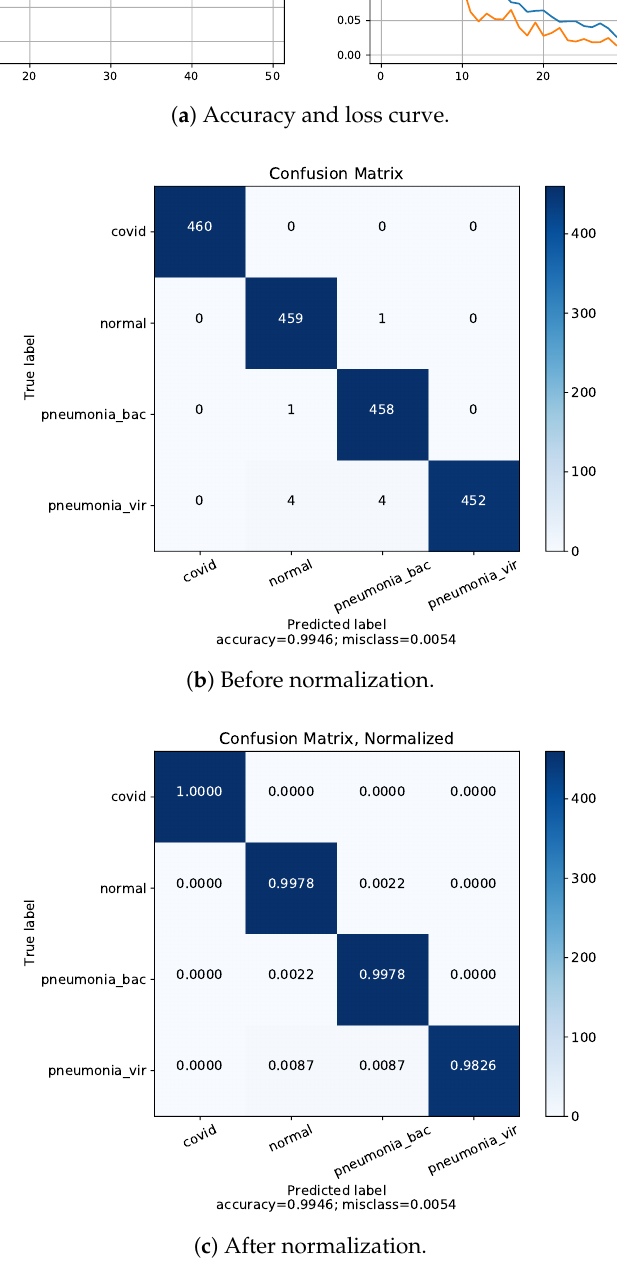
Figure 8. Results of Dataset-2 for 4-class COVID-19/normal/bacterial pneumonia/viral